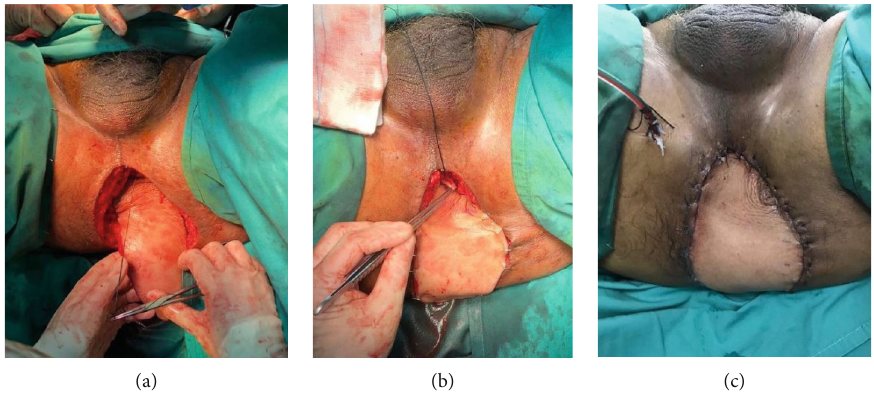
Figure 3: (a – c) Harvested rectus fl ap tunnelled into the